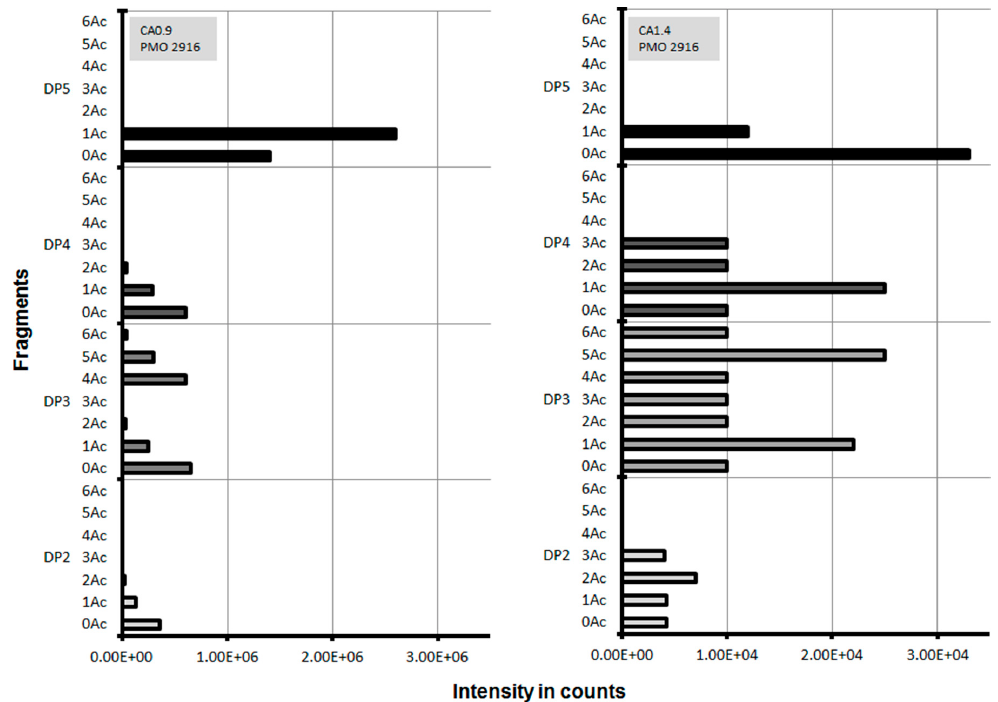
Figure 6. Hydrolysis of cellulose acetates with different degree of acetylation (CA0.9, CA1.4) by lytic polysaccharide monooxygenases (LPMO 2916) monitored using LC ‐ TOF ‐ MS. Degree of polysaccharide monooxygenases (LPMO 2916) monitored using LC-TOF-MS. Degree of polymerization polymerization (DP); number of acetyl groups per fragment (Ac). (DP); number of acetyl groups per fragment